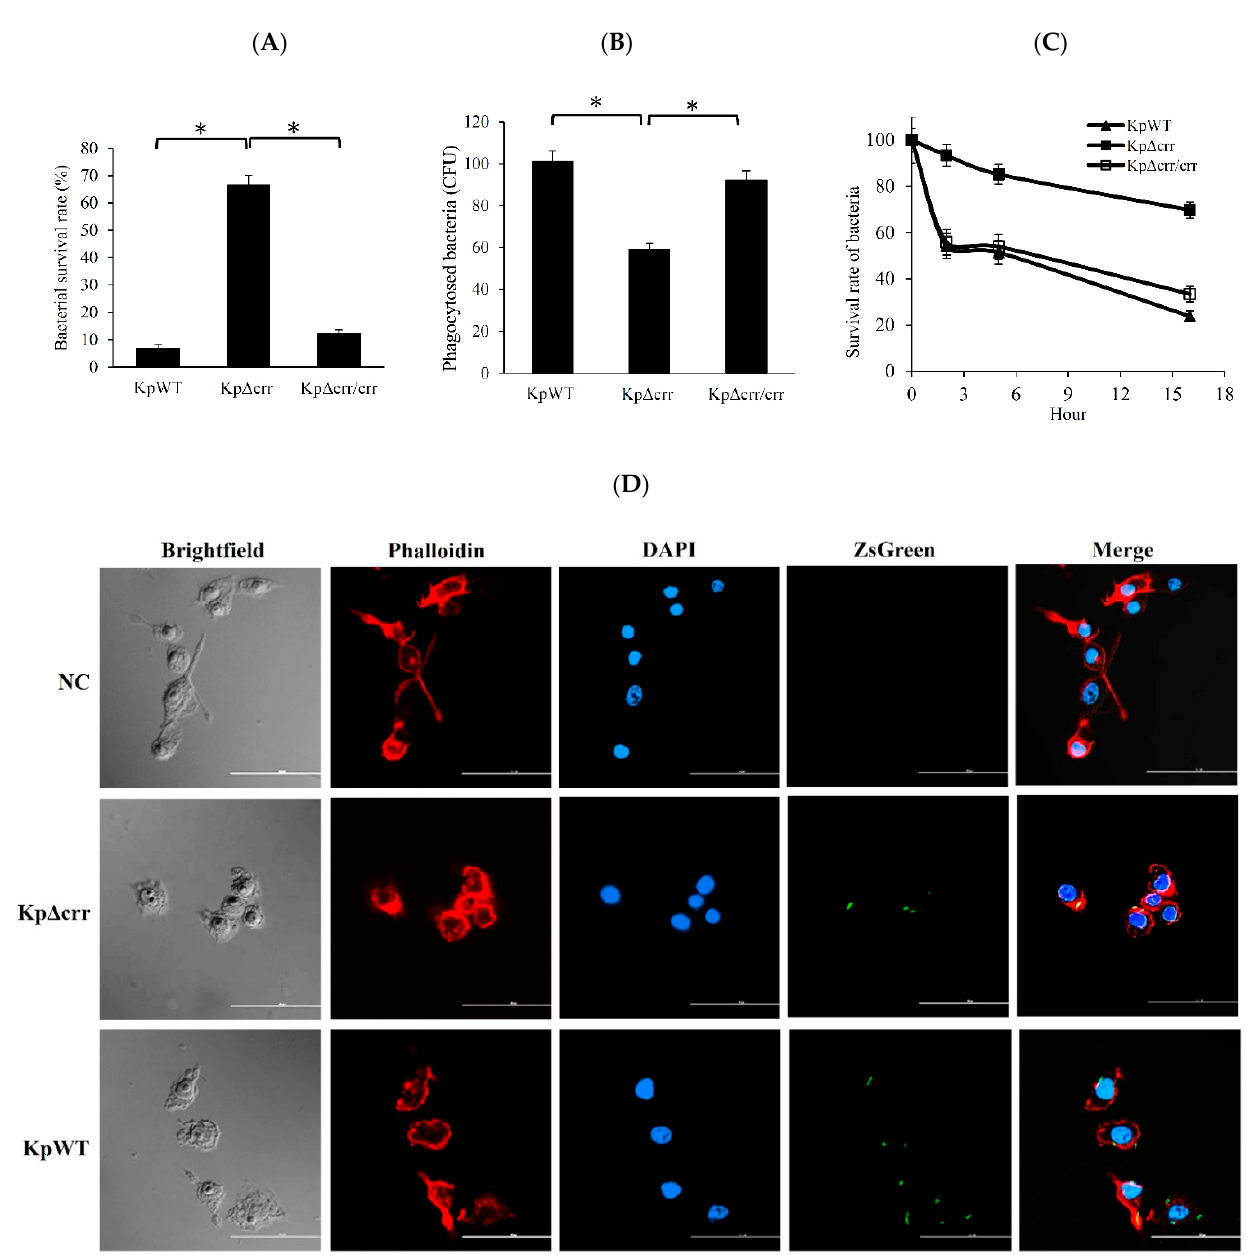
Figure 4. The effect of crr on resistance to hydrogen peroxide, macrophage ingestion and bactericidal activity in macrophages. ( A ) Survival rate of bacteria exposed to 1% hydrogen peroxide for 30 min. The survival rate of each strain was calculated by dividing the CFU of bacteria with H 2 O 2 treatment by the CFU of bacteria without H 2 O 2 treatment. ( B ) Evaluation of bacteria ingested by macrophages. After 1 h of infection and 30 min of antibiotic treatment, the macrophages were lysed and plated to calculate the recovery of intracellular bacteria. Values shown are the mean CFU of viable bacteria per well ± SD of three independent experiments. ( C ) Survival rate of intracellular bacteria resistant to phagocytosis by macrophages after 1 h of infection, 30 min of antibiotic treatment and incubation for 2, 5 or 16 h. The survival rate of each strain was calculated by dividing the CFU of viable bacteria after incubation by the CFU of viable bacteria without incubation (0 h). ( D ) Internalization of bacteria by macrophages observed by CLSM. The macrophages were infected for 1 h with bacteria carrying pBSK-Km::ZsGreen (green). After 30 min of antibiotic treatment, the cells were visualized by staining F-actin with phalloidin (red). The cell nuclei were stained with DAPI (blue). Representative 2D images were acquired by choosing the maximum intensity projection from 3D CLSM images in three different experiments. Scale bar (white horizontal line in each subfigure) = 50 µ m. NC: no bacteria, as a negative control. KpWT: K. pneumoniae STU1 wild-type. Kp ∆ crr: K. pneumoniae